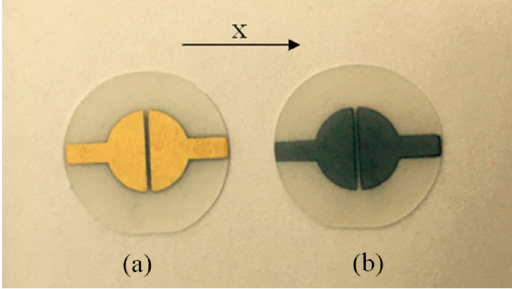
Figure 2. The photos of the (yxl) 13.8° Langatate (LGT) LFE device: ( a ) the side with electrode, ( b ) the side with no electrode.